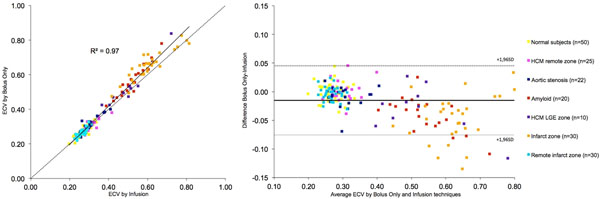
Correlation and Bland-Altman Analysis of the comparison between Bolus only and Infusion techniques across health and disease. There is a bias towards ECV overestimation in those diseases where the ECV >0.4, and this appears to increase with increasing ECV (amyloid, HCM LGE, chronic infarct zones). The dashed lines denote the line of identity in the scatterplot, and the mean ± 1.96SD in the Bland-Altman plots for all subjects combined.